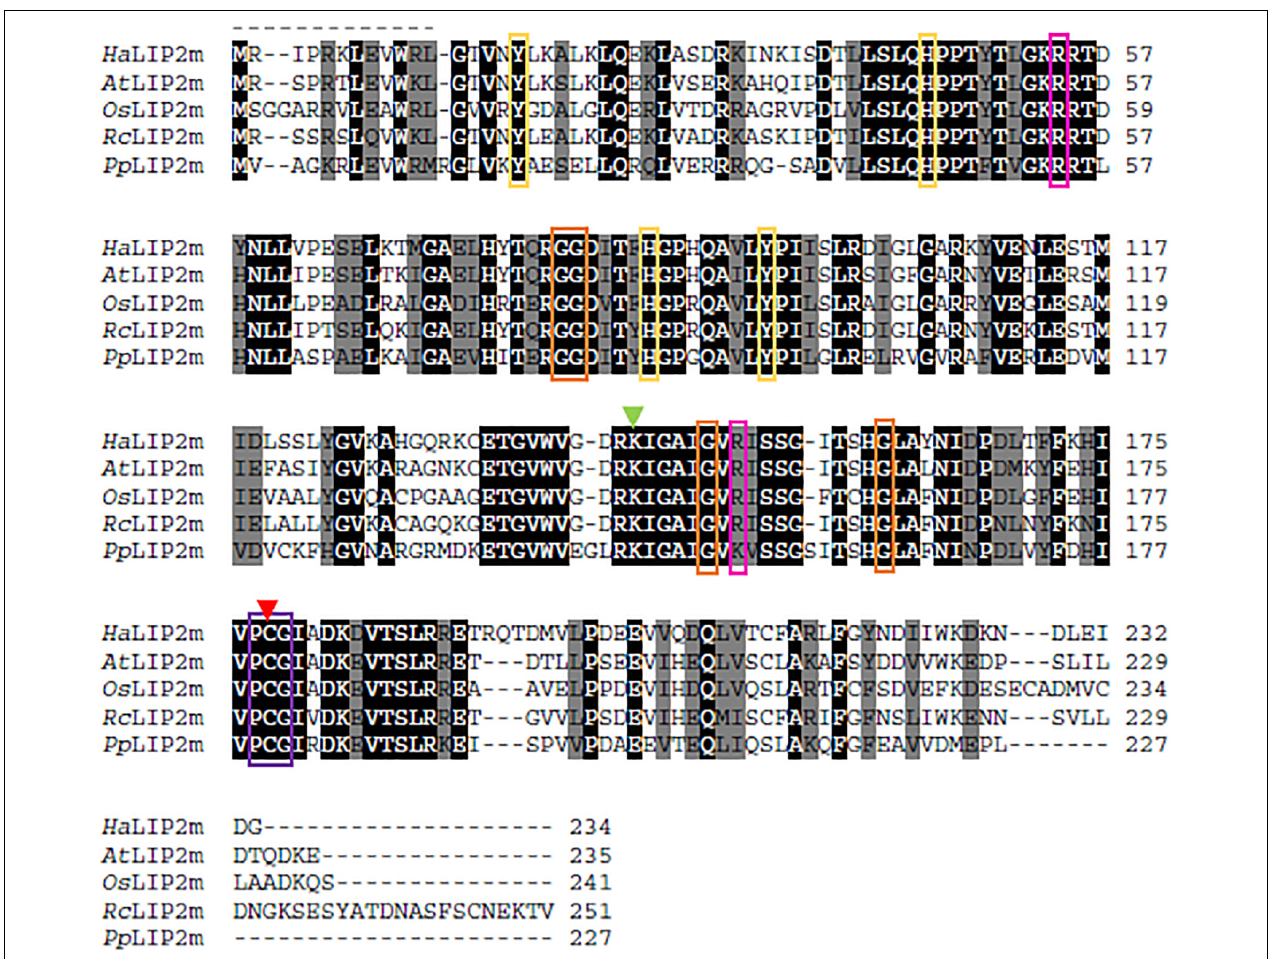
FIGURE 3 | Alignment of the sunflower octanoyltransferase ( Ha LIP2m) amino acid sequence with homologous sequences from species in different phylogenetic groups: Arabidopsis thaliana ( At LIP2m; NP_001030961.1); Ricinus communis ( Rc LIP2m; XP_015578958.1); Oryza sativa ( Os LIP2m; XP_015631649.1); and Physcomitrella patens ( Pp LIP2m; XP_024367327.1). Identical evolutionarily conserved residues are highlighted in black and highly conserved residues are highlighted in gray. Residues involved in substrate binding are indicated with a green (Lys) or red arrow (Cys). The conserved PCG motif is indicated by a purple box, while Gly residues involved in the formation of the cavity where the substrate is allocated are in orange boxes. Aromatic residues that presumably interact with the substrate are indicated by yellow boxes and other positively charged residues surrounding the access to the active site are in pink